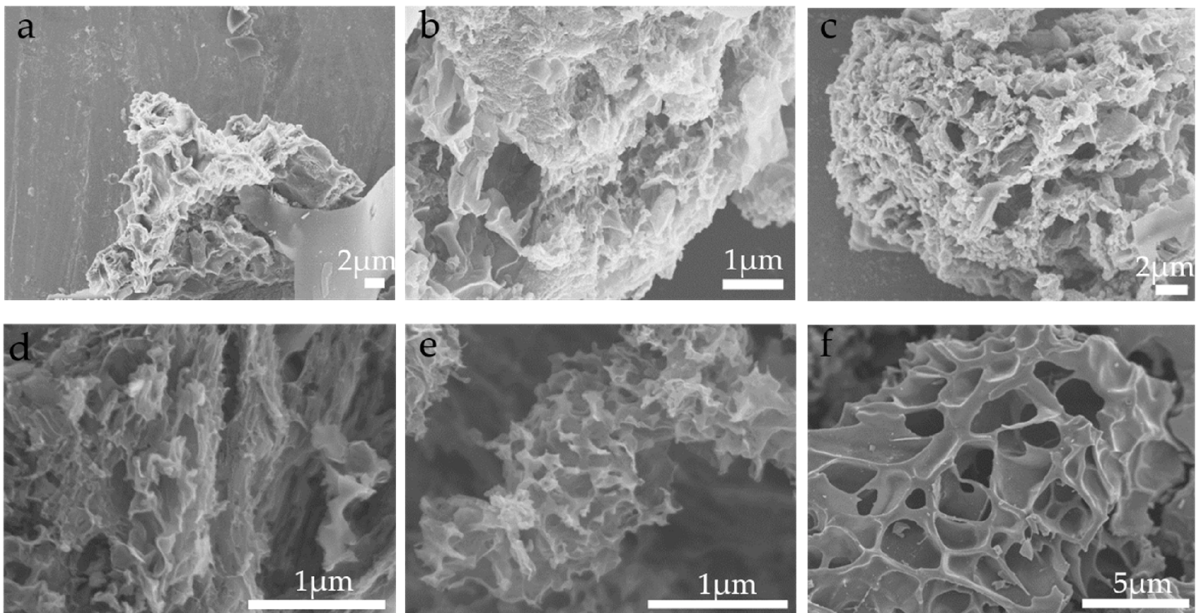
Figure 1. SEM images for ( a ) CA–600, ( b ) CA–800, ( c ) CA–1000, ( d ) AlCA–600, ( e ) AlCA–800 and ( f ) AlCA–1000. Table 1. The BET parameters of CAs and AlCAs. BET Surface Adsorption Average Pore as /m 2 g − 1